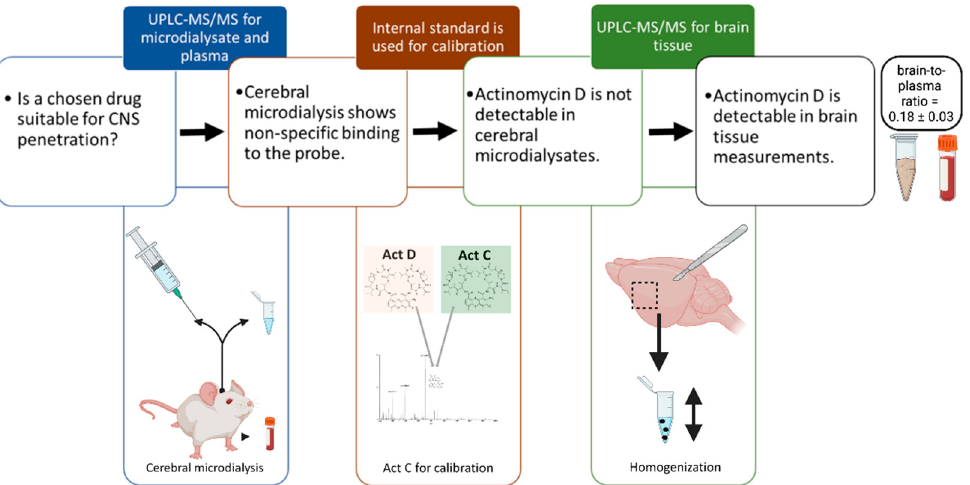
Figure 5. Schematic workflow of the methodology for determining the central nervous system (CNS) drug disposition of actinomycin D (Act D). Despite the use of actinomycin C (Act C) for probe calibration and avoiding nonspecific binding of actinomycin D to the microdialysis equipment, only whole brain tissue measurements were suitable for measurement of the drug´s brain disposition. Created with BioRender (Biorender AG, Münchwilen, Switzerland).